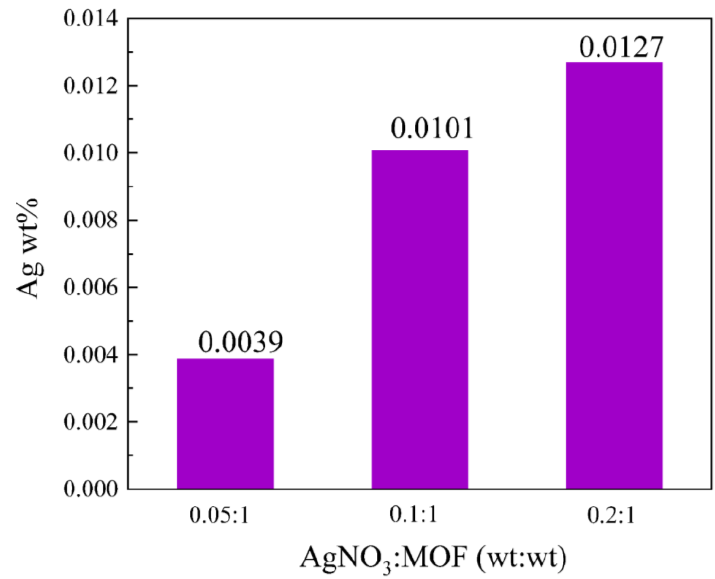
Figure 4. Ag-ion loading of MIL-101(Fe)@Ag with different mass